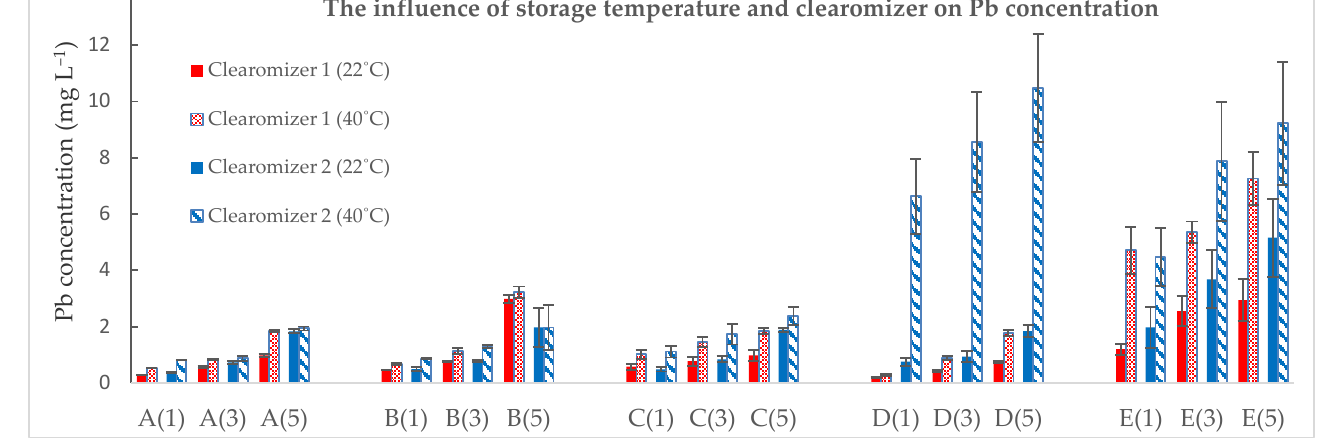
Figure 2. The influence of storage temperature and of the clearomizer on Pb concentration. Sample code: Sample number (number of storage days in the clearomizer).